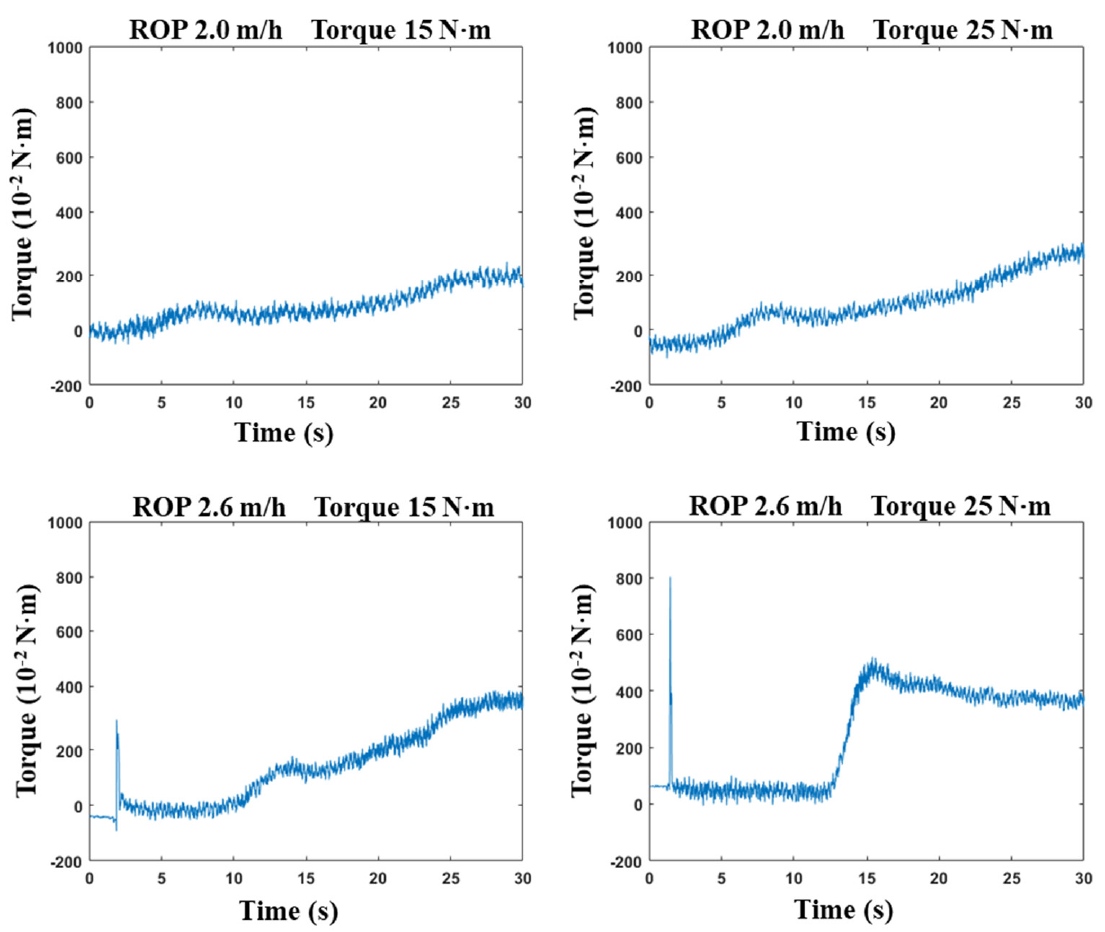
Figure 12. Test results for constant-speed drilling mode: the curves of torque at different setpoints.